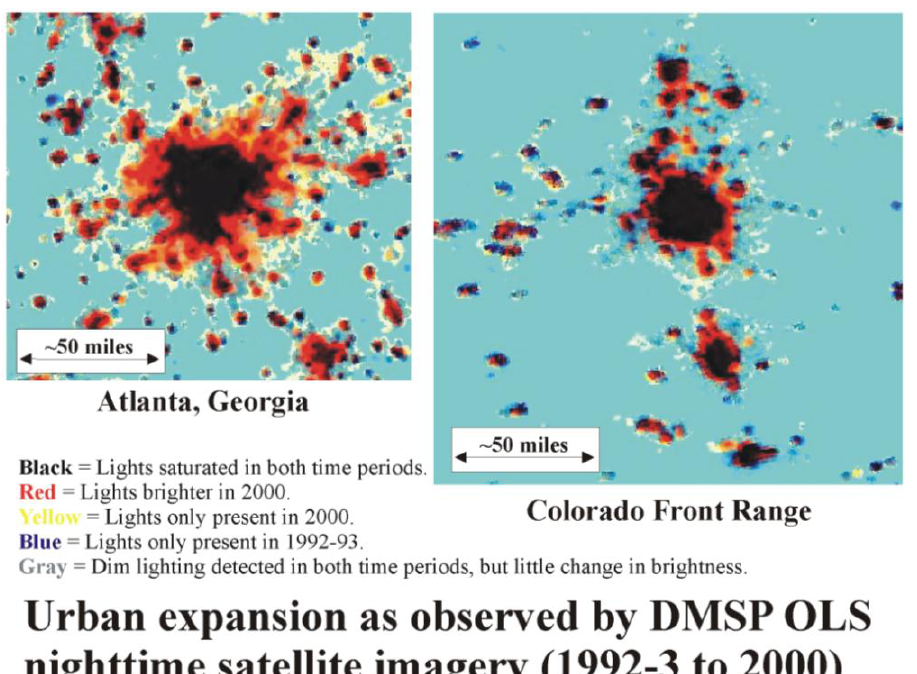
Figure 2. Use of DMSP OLS to monitor urban growth in Atlanta Georgia and the Colorado Front